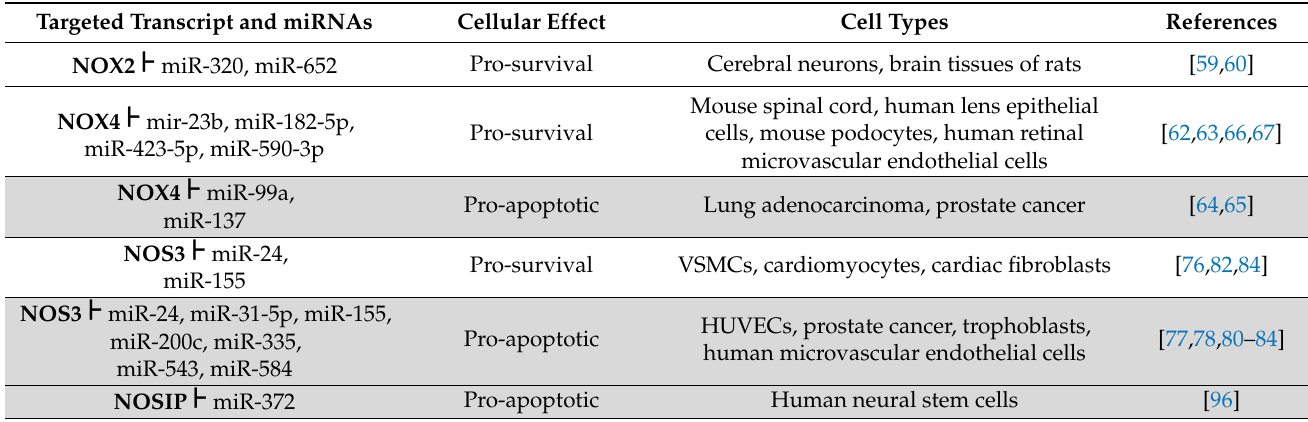
Table 1. Cellular effects of an increased level of miRNAs which target transcripts for enzymes producing ROS and RNS. MiRNAs in grey rows show an opposite effect on cell survival to those in white rows.